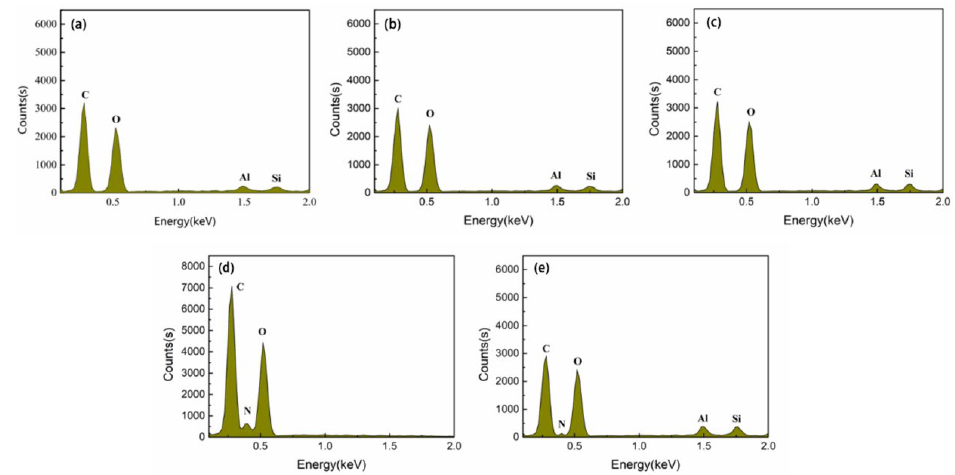
Figure 7. EDS diagram of natural MMT/CA composite fiber membrane modified MMT composite fiber membrane and CTS: ( a ) MMT/CA composite fiber membrane; ( b ) 3 wt% HCl-MMT/CA composite fiber membrane; ( c ) 4 wt% SDS-MMT/CA composite fiber membrane; ( d ) CTS; ( e ) 5 wt% CTS-MMT/CA composite fiber